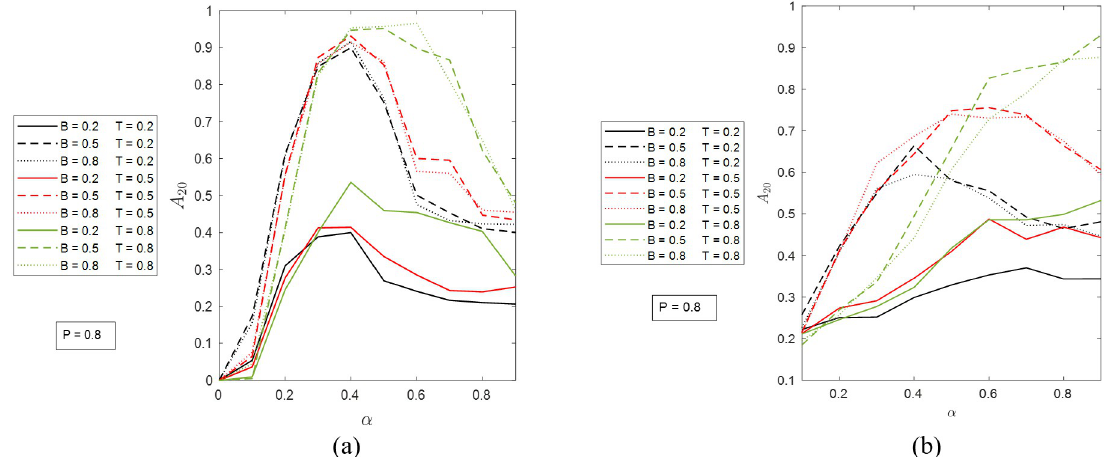
Fig 5. The portion of active nodes at time step 20 when P = 0.8 in (a) the ER network and (b) the SF network. The possible values of B and T are 0.2, 0.5, and 0.8. The values of α are from 0 to 0.9 at step size 0.1.